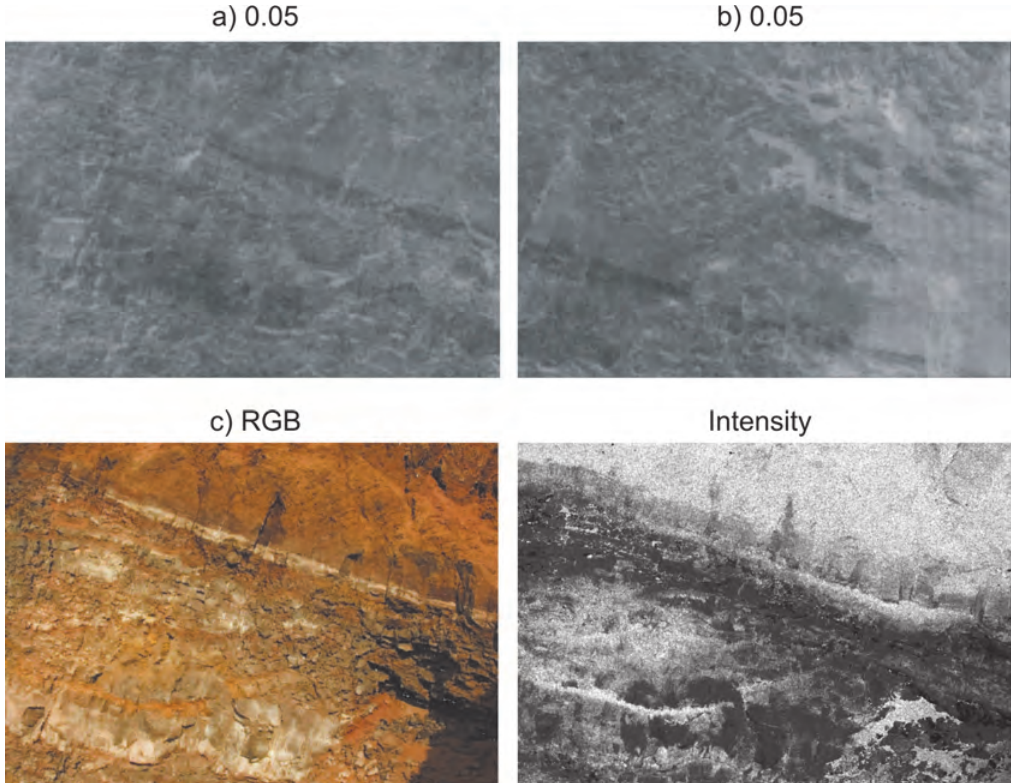
Fig. C1. PCA of the intensities in a case where two viewpoints are considered, with different distances and ori- entations: two scans with intensity data (a,b), transformed dataset, i.e. virtual image (c). All the features that can be separately detected in the two single scans can be easily found in the principal